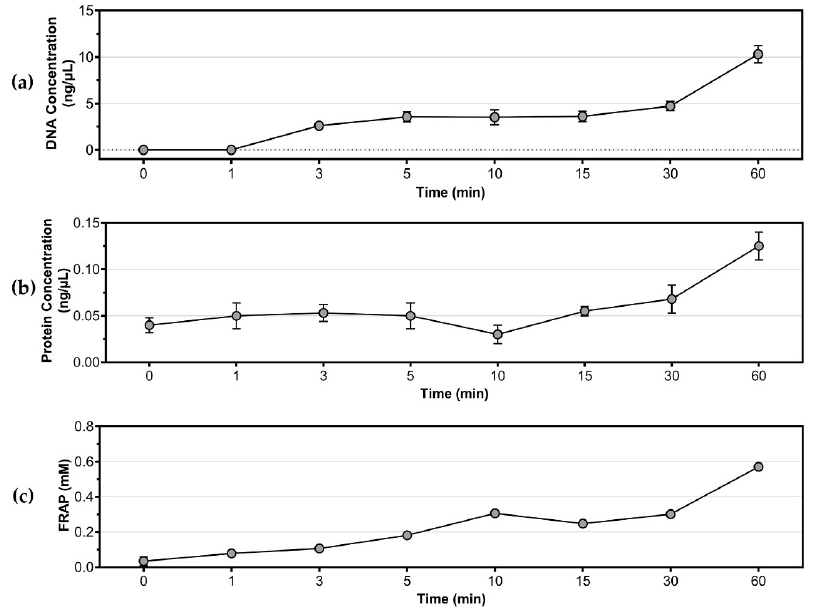
Figure 4. Detection of intracellular components and antioxidants in culture supernatant. ( a ) Concentration of DNA; ( b ) concentration of protein; ( c ) total antioxidant activities of S. aureus as determined by FRAP assay (equivalent to mM FeSO 4 ).